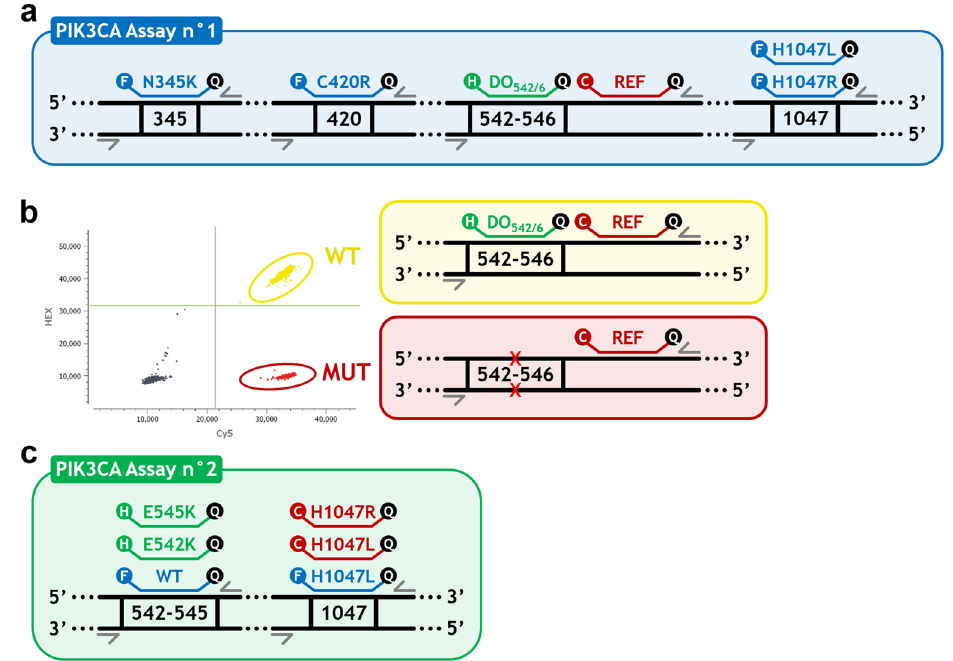
Figure 1. Design diagrams of the two multiplex assays for PIK3CA mutations detection and Drop-Off 542–546 system principle. ( a ) Design diagram of the PIK3CA Assay n°1: four amplicons are simultaneously amplified using four couples of primers (grey arrows) to permit the detection of N345K, C420R, H1047L and H1047R mutations using FAM-labelled probes (blue color), as well as mutations on codons 542–546 using a HEX- labelled drop-off probe (green color) combined with a Cy5-labelled reference probe (red color). ( b ) Drop- Off 542–546 system principle: WT sequences are detected by both the HEX-labelled drop-off probe and the Cy5-labelled reference probe, thus producing a cluster of HEX-Cy5 double-positive droplets (yellow-colored cluster on the 2D dot plot); whereas sequences bearing mutations (MUT, red crosses) on codons 542 to 546 have sub-optimal or even absent drop-off probe detection (red-colored cluster on the 2D dot plot). ( c ) Design diagram of the PIK3CA Assay n°2: two amplicons are simultaneously amplified using two couples of primers to permit the detection of wild-type (WT) sequences using a FAM-labelled probe, E542K and E545K mutations using HEX-labelled probes, H1047L mutation using FAM and Cy5-labelled probes and H1047R mutation using a Cy5-labelled probe ( C: Cy5; DO: drop-off; F: FAM; H: HEX; MUT: mutation; REF: reference )